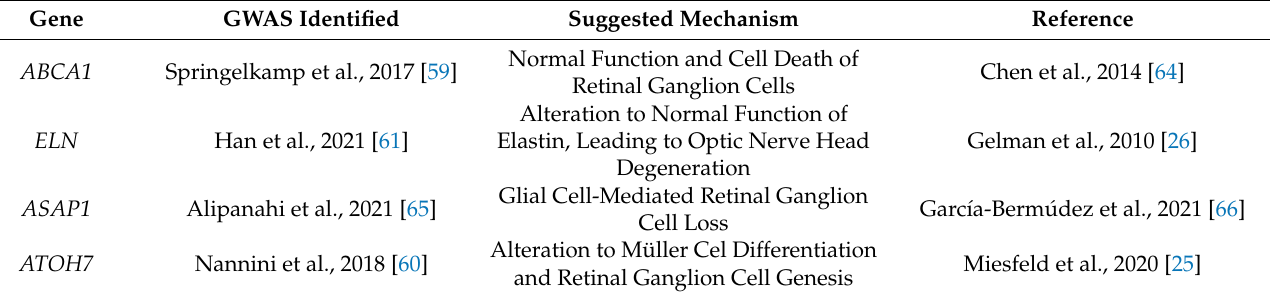
Table 3. Selection of genes associated with CDR and suggested molecular mechanisms.